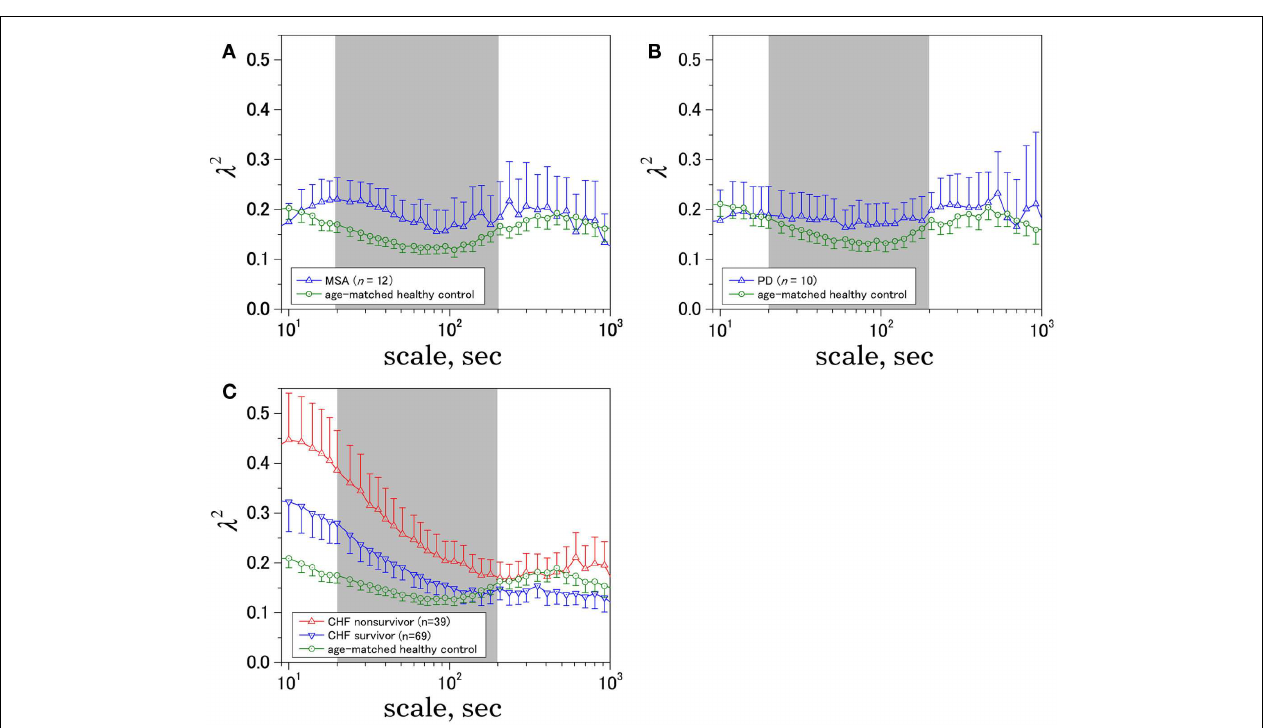
and non-survivor (NS; n = 39). Age-matched controls were selected from a database of healthy subjects. Error bars indicate 95%-confidence intervals of the group